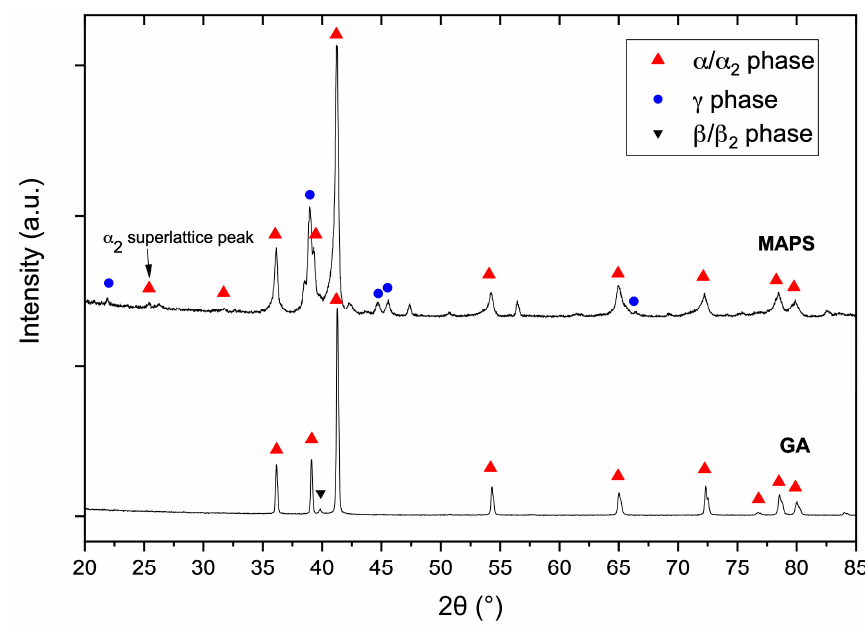
Figure 3. X-ray di ff raction (XRD) patterns of MAPS and GA powders. Figure 3. X-ray diffraction (XRD) patterns of MAPS and GA powders.